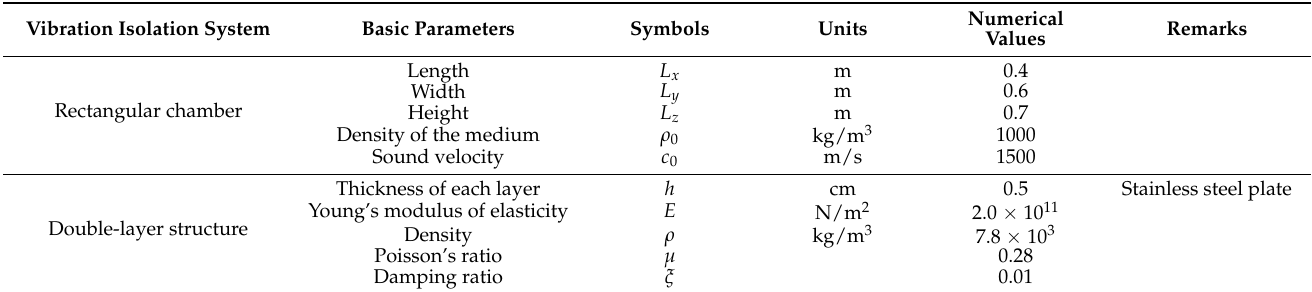
Table 1. Setting of system’s basic parameters.